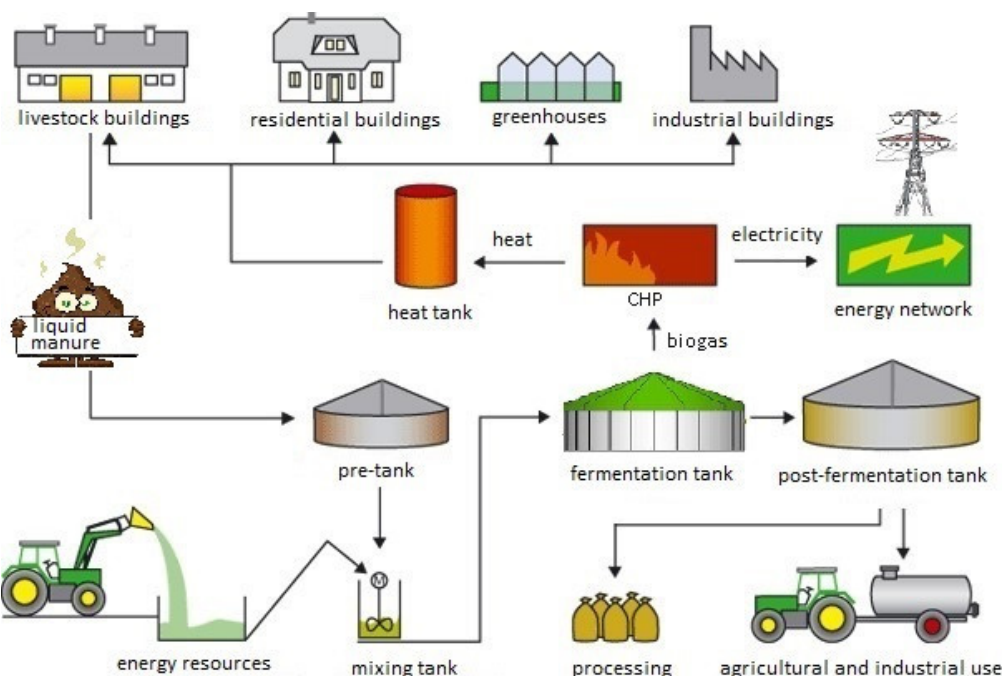
Figure 1. Scheme of waste utilization for green energy production. Source: own elaboration based on [27].